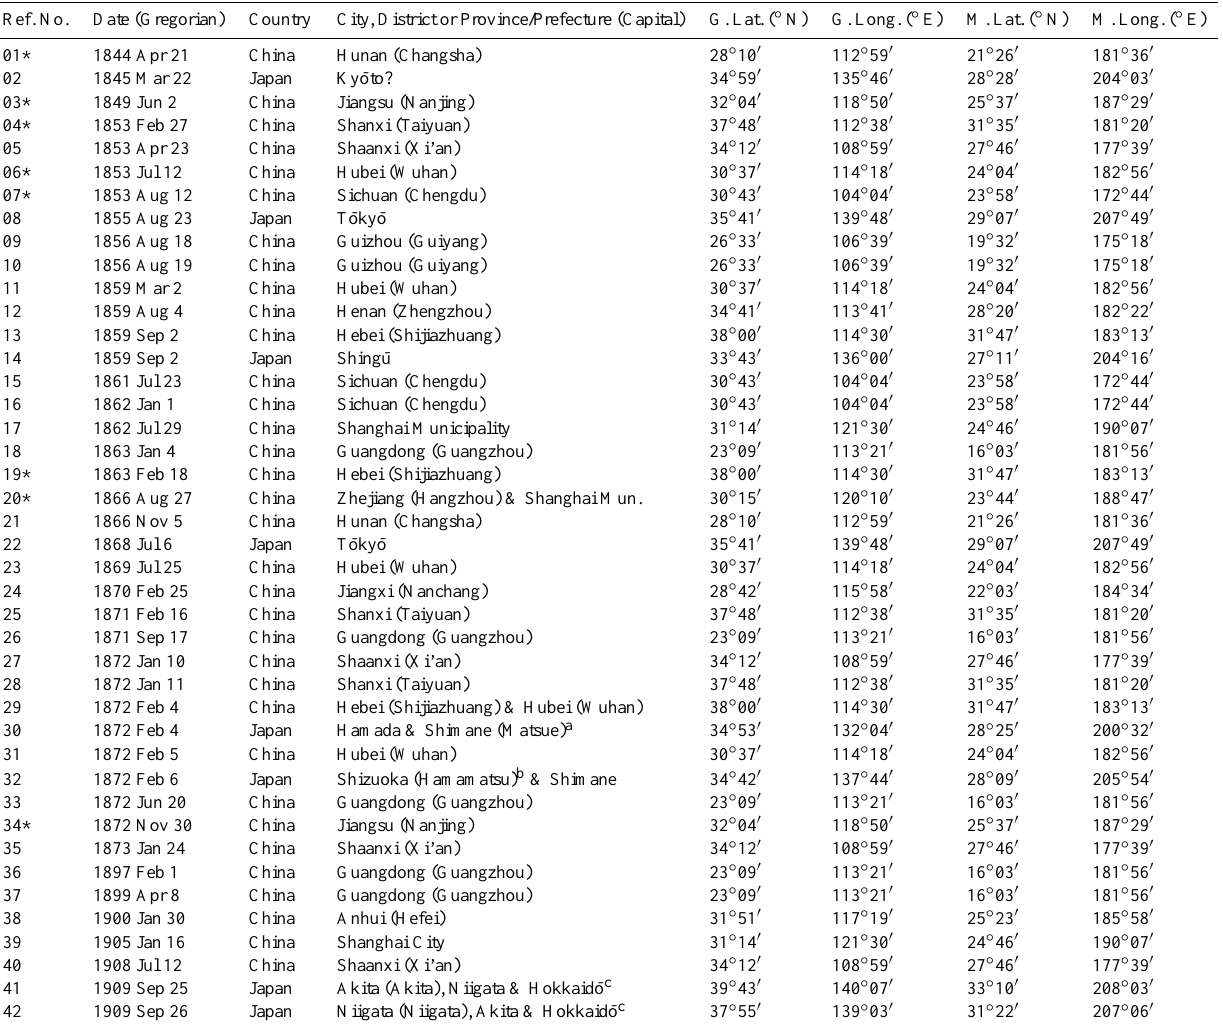
Table 1. Exactly dated Chinese and Japanese auroral observations recorded during the interval AD 1840–1911. After a chronological reference number (Ref. No.), introduced to facilitate cross-referencing, the exact Gregorian date of each auroral observation is given, followed by the country and then the city, district or province/prefecture of the place of observation (see Appendix A for further details). An asterisk (*) qualifies the reference number if the associated Chinese auroral observation is from the “not definite category” (Beijing Observatory, 1988), rather than the “definite category”, as discussed in Sect. 2. If the auroral observation was made in a Chinese province or Japanese prefecture, the present-day capital of that province or prefecture is given in parentheses. Also listed are the geographic co-ordinates (G. Lat., G. Long.) and magnetic co-ordinates (M. Lat., M. Long.) of each location or present-day capital. If a Chinese or Japanese auroral display was observed from two or more locations on the same night (e.g. Zhejiang & Shanghai and Akita, Niigata & Hokkaid¯o), the geographic, and hence magnetic, co-ordinates apply to the first location (although the co-ordinates of the other locations usually appear elsewhere in this table; otherwise, they are given in the footnote). The magnetic co-ordinates are corrected geomagnetic co-ordinates for epoch AD 1900 (see Sect.